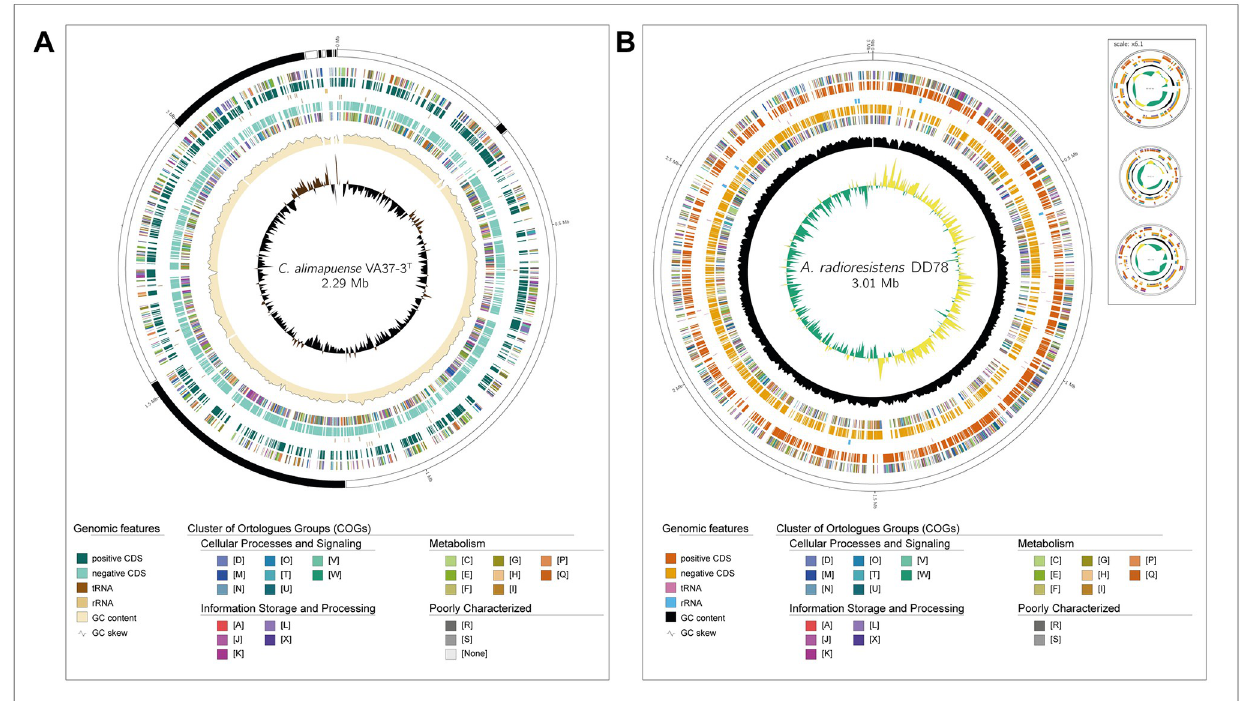
Fig 2. Application of GenoVi using a draft or complete bacterial genome. (A) GenoVi circular map of the draft genome of Corynebacterium alimapuense VA37-3 T [18] ( -s draft -cs paradise ). Each contig is represented as separated bands of one circular representation. (B) GenoVi circular representation of the complete genome of Acinetobacter radioresistens DD78 [21] (-s complete , -cs autumn ). Each circular map represents a replicon from the complete genome. A . radioresistens DD78 genome consists of a circular chromosome and three circular plasmids displayed next to the chromosome ( —scale variable). Labeling from outside to the inside: Contigs; COGs on the forward strand; CDS, tRNAs, and rRNAs on the forward strand; CDS, tRNAs, and rRNAs on the reverse strand; COGs on the reverse strand; GC content; GC